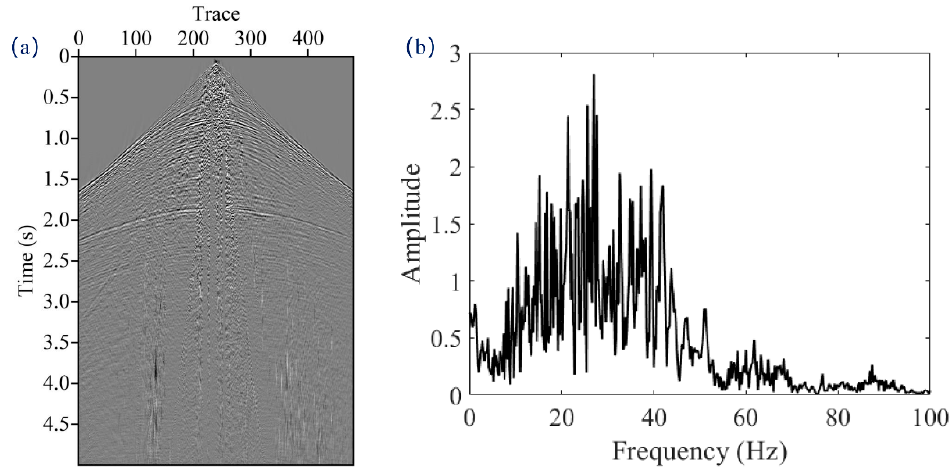
Figure 11. ( a ) The observed seismogram selected from the 200th shot, ( b ) the corresponding amplitude spectrum.